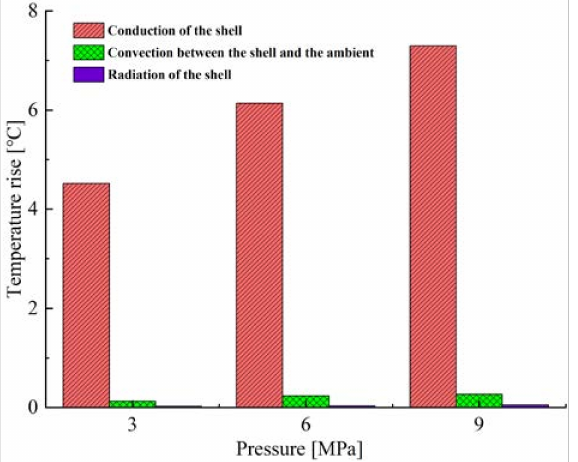
Figure 14. Comparison of the temperature rise of the three heat dissipation